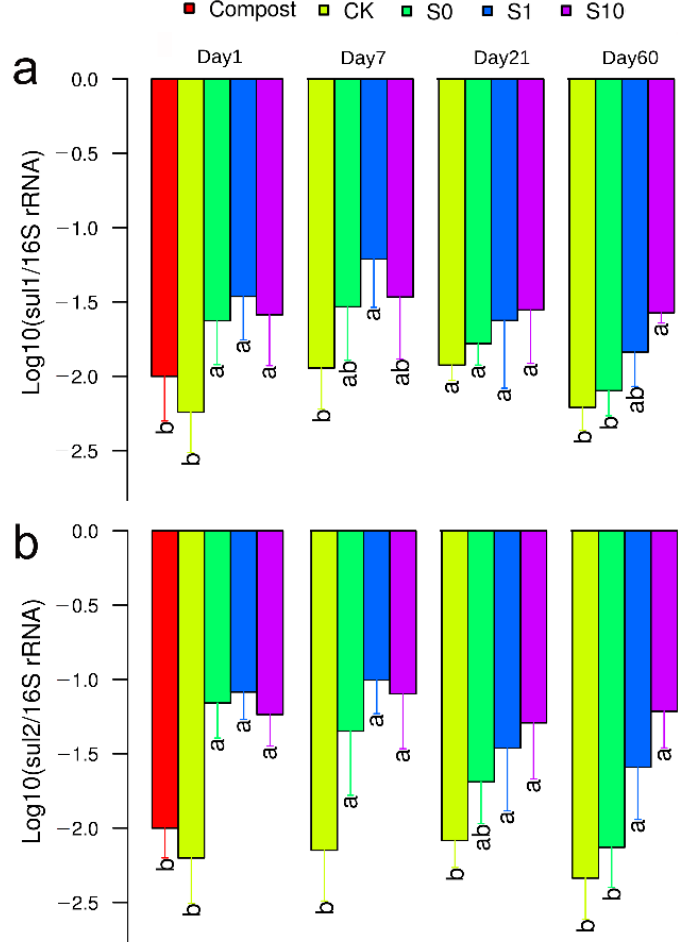
Figure 2. The relative abundance of sul1 ( a ) and sul2 ( b ) in different treatments. CK: soil; S0: soil amended with compost; S1: soil amended with compost and 1 mg kg − 1 of sulfadiazine; S10: soil amended with compost and 10 mg kg − 1 of sulfadiazine. The different letters above the columns in the same sampling indicate significant differences ( p < 0.05) between treatments.